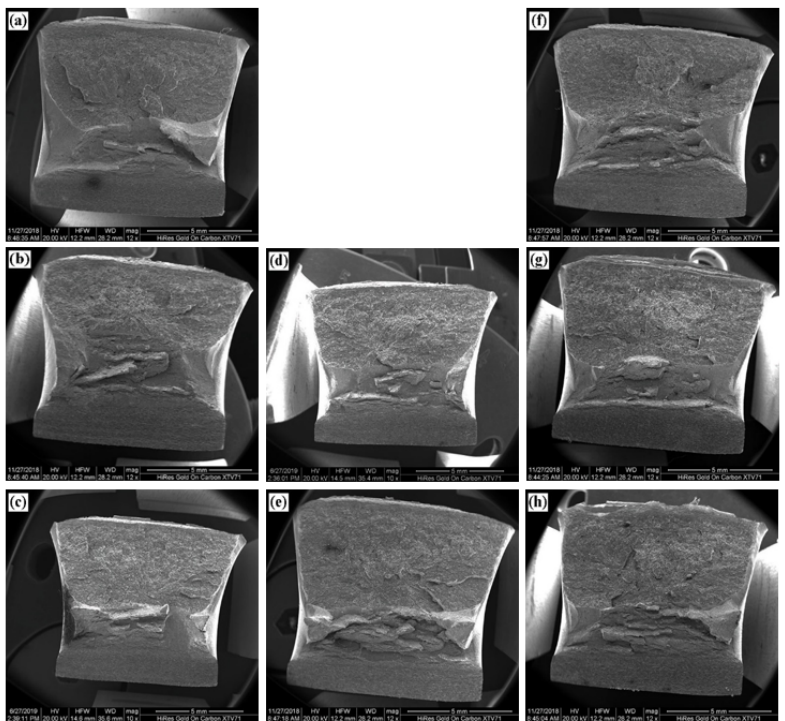
Figure 10. Impact fractographs at the different temperature measurement points. Images ( a – h ) exhibit the results for points P1–P8, respectively.